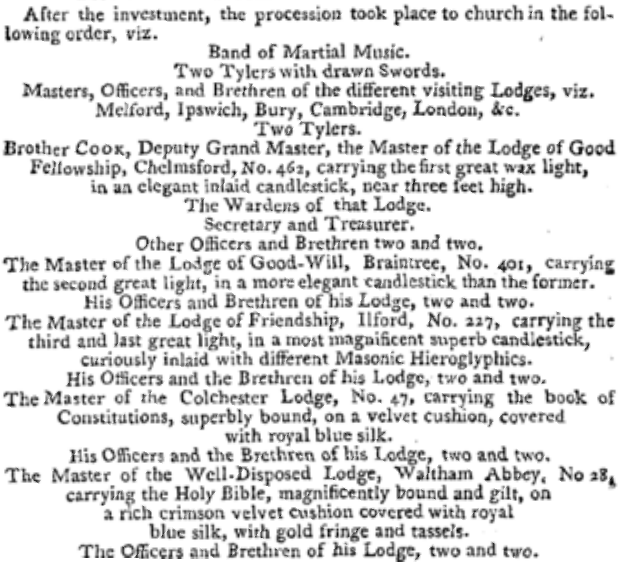
Fig. 3. The Freemasons’ Magazine (1 August 1793), p.